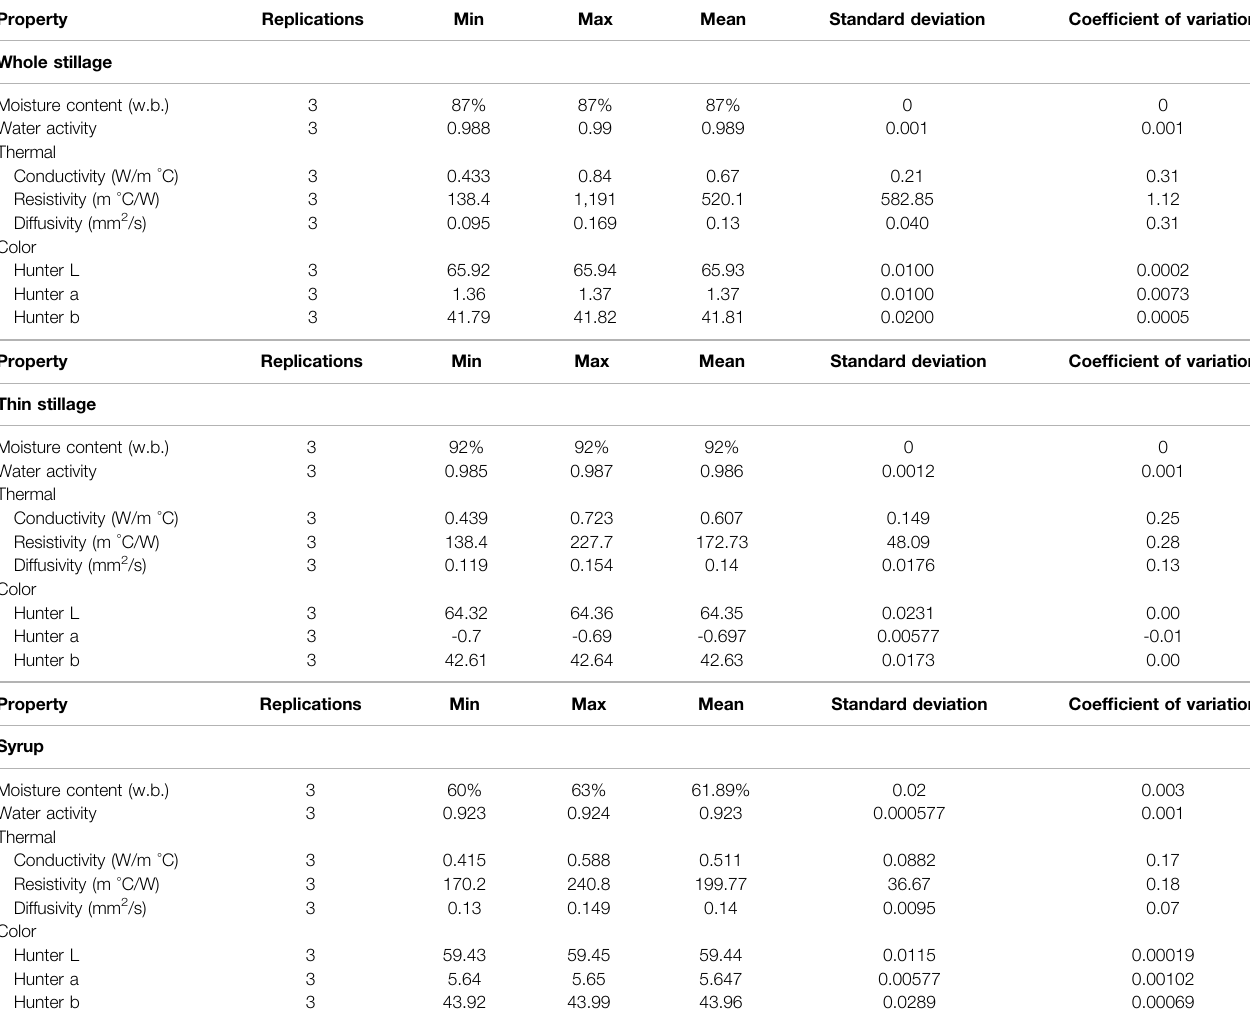
TABLE 2 | Initial properties of whole stillage, thin stillage, and syrup at t (cid:1) 0. a